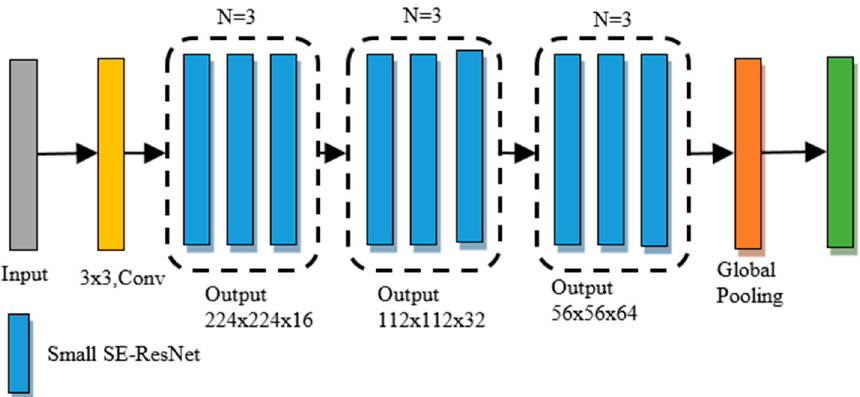
Figure 5. The architecture of the BHCNet-3.